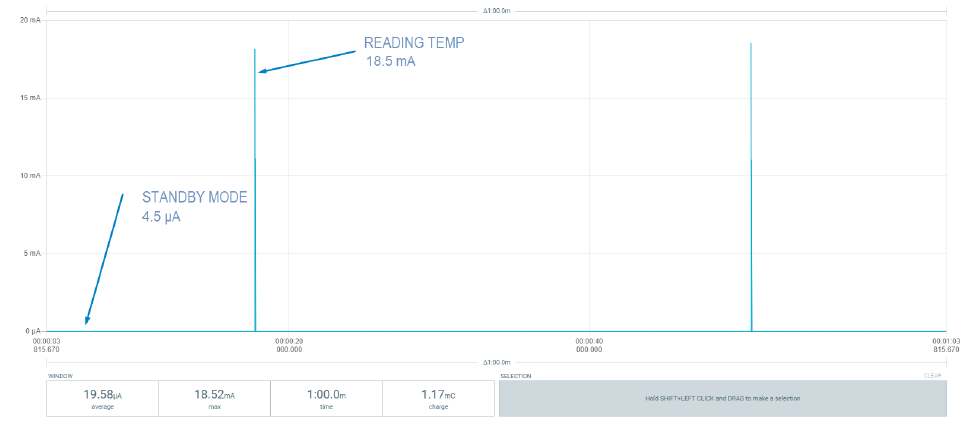
Figure 11. STM32 node: Low-power mode (standby mode) and sensor reading.